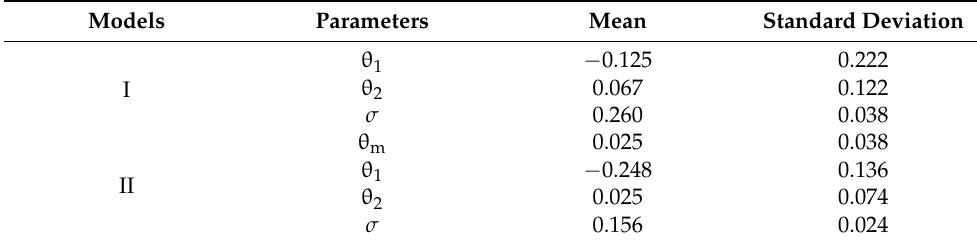
Table 2. Posterior statistics of unknown parameters in the strength degradation model. Models Parameters